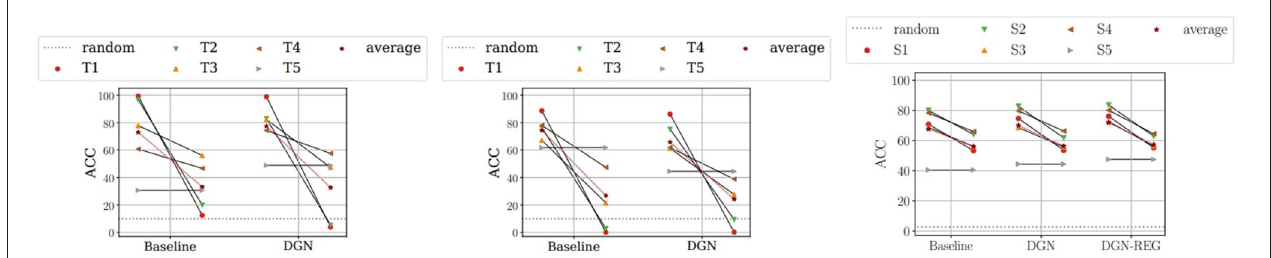
FIGURE 1 | Paired plots showing the ACC on each step for different models for LWF and MNIST (left) , LWF and CIFAR10 (middle) , Replay and OGBG-PPA (right) . Complete plots in the Supplementary Material . Each column refers to a model and it is composed by pairs of connected points. Each pair refers to a specific step. The leftmost point in the pair represents ACC after training on that specific step. The rightmost point represents ACC after training on all steps. The more vertical the line connecting the points, the larger the forgetting effect. The dashed horizontal line indicates the performance of a random classifier. The red star represents the average performance over all steps.